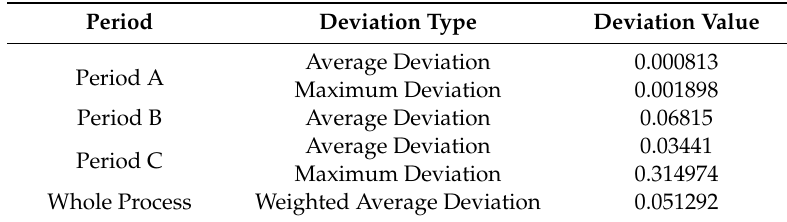
Table 4. Model evaluation of active current under large disturbance of grid voltage.